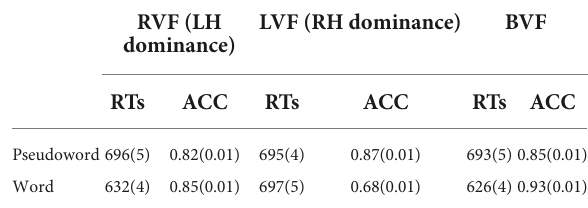
TABLE 7 Response times (RTs) and accuracy (ACC) at the RVF, LVF, and BVF for words and pseudowords were